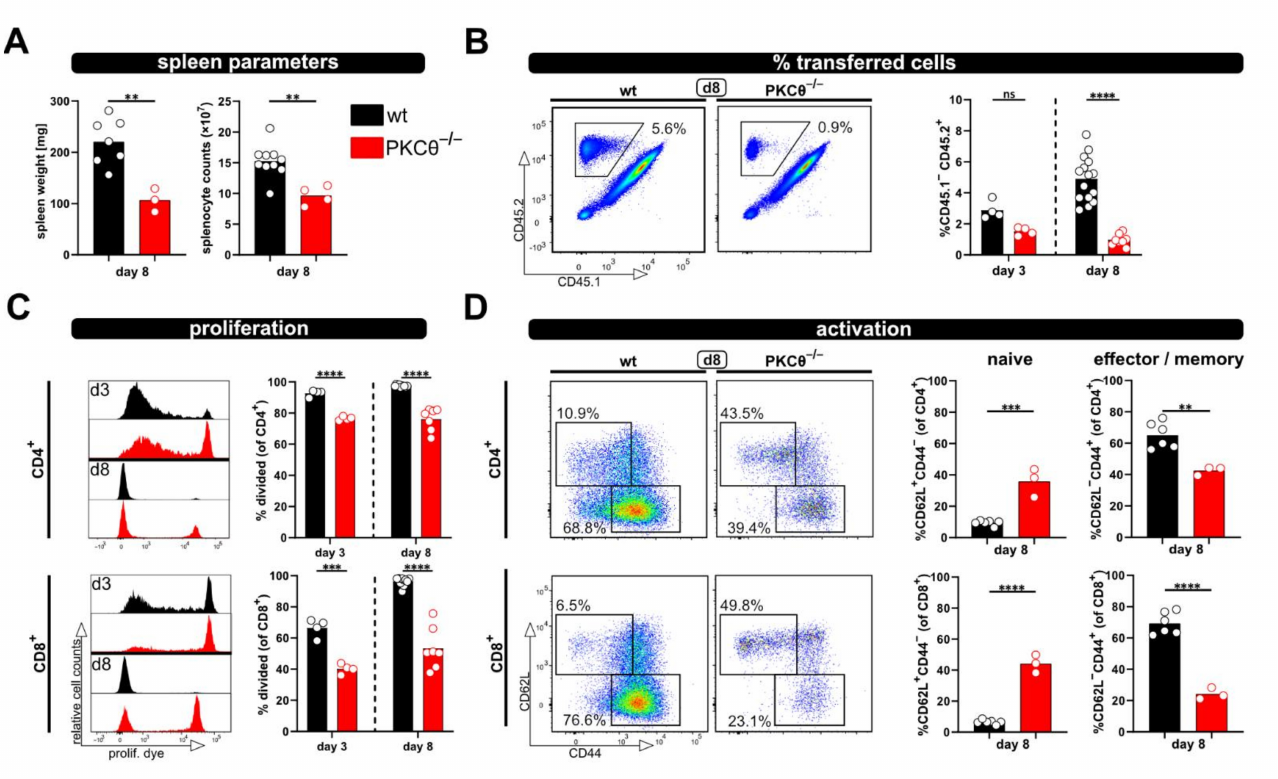
Figure 3. Using PKC θ -/- T cells in the modified P → F1 approach as an example of a hypo-reactive T cell response. ( A ) Spleen weight and splenocyte counts were determined at day 8 after ACT of 8 × 10 6 wild type or PKC θ -deficient CD3 + T cells to allogenic recipients. ( B , C ) Flow cytometric analysis of the frequency ( B ) or proliferation ( C ) of either transferred wild type or PKC θ -/- T cells in the spleens of allogenic recipients at day 3 and 8 after ACT. ( D ) Naive and effector/memory subsets of transferred CD4 + and CD8 + T cells, either wild type or PKC θ -/- , were analyzed at day 8 in the spleens of allogenic recipients. Data are represented as individual values plus mean. Representative FACS dot plots or histograms of individual mice are shown. ns = not significant, ** p < 0.01, *** p < 0.001, **** p < 0.0001; ( A , D ) unpaired t -test; ( B , C ) one-way ANOVA following Bonferroni’s post hoc